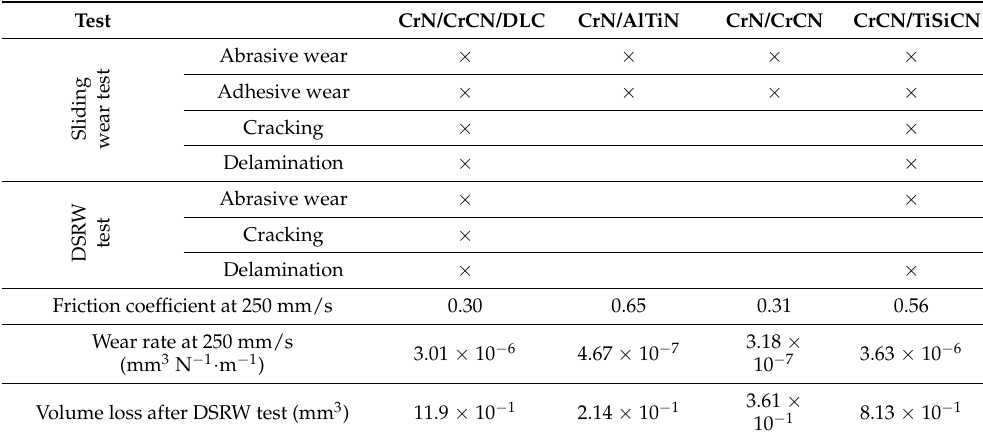
Table 6. Assessment of coating characterization following wear tests.